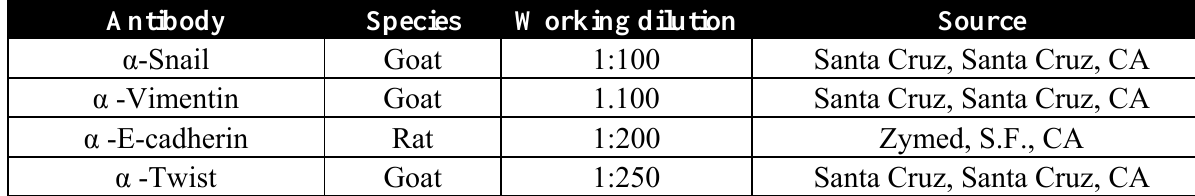
Table 1. Concentrations and source of primary